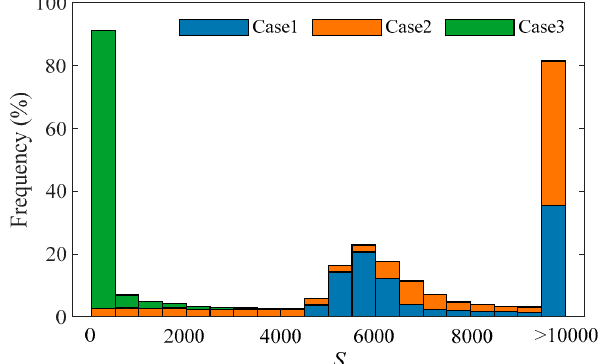
Figure 12. The distribution of S in different cases.